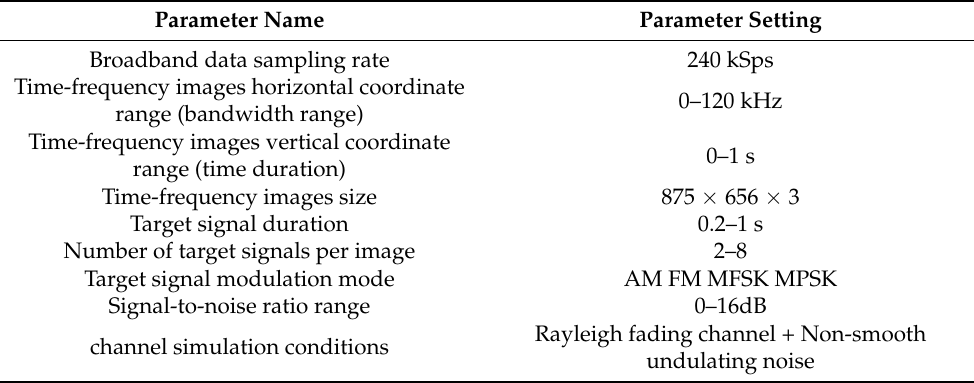
Table 1. Training dataset parameter setting.